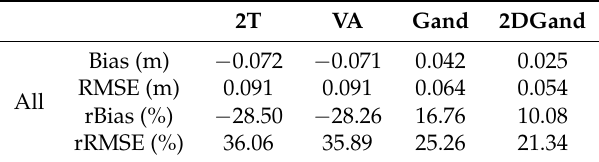
Table 4. Bias, RMSE, relative bias and relative RMSE of the various estimators summarized for all sites using a distance-only clustering method. All other used parameters and methods are identical to Table 3.